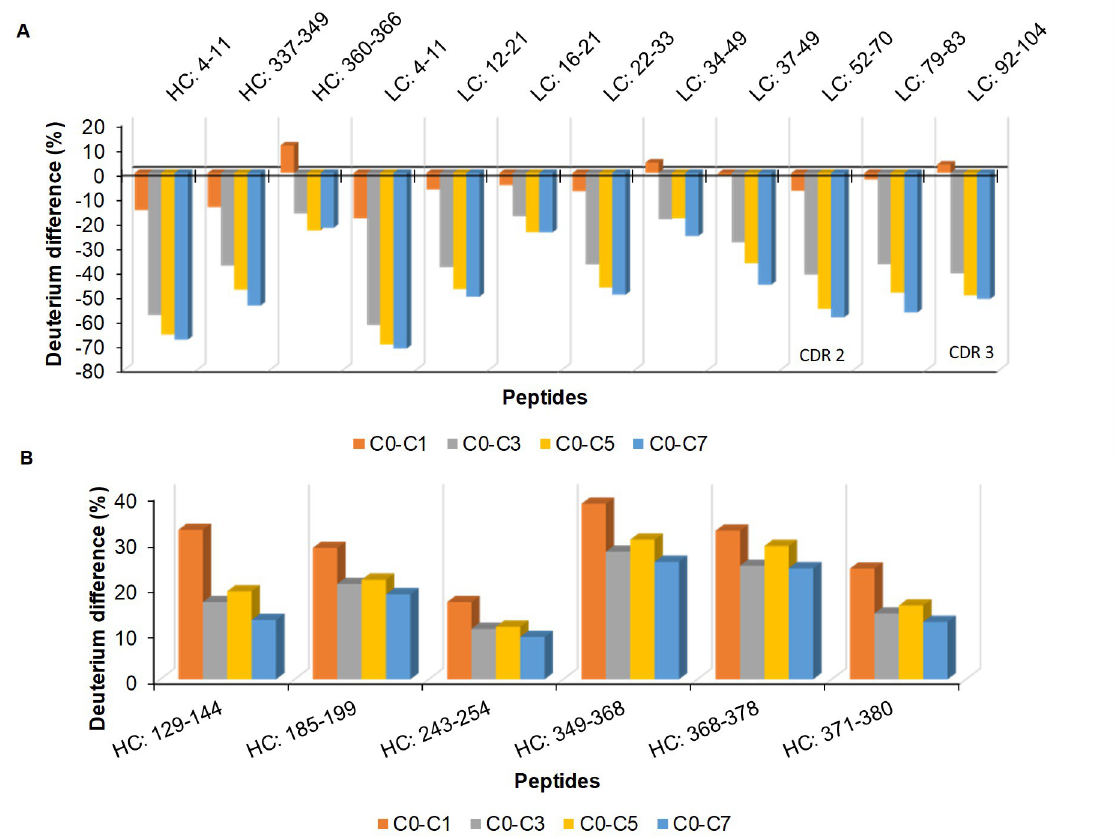
Fig 7. Differences of deuterium incorporation for E559 (A) and 62-71-3 (B). Deuterium incorporation in cycle 0 was deducted from cycle 1 (orange), 3 (grey), 5 (yellow) and 7